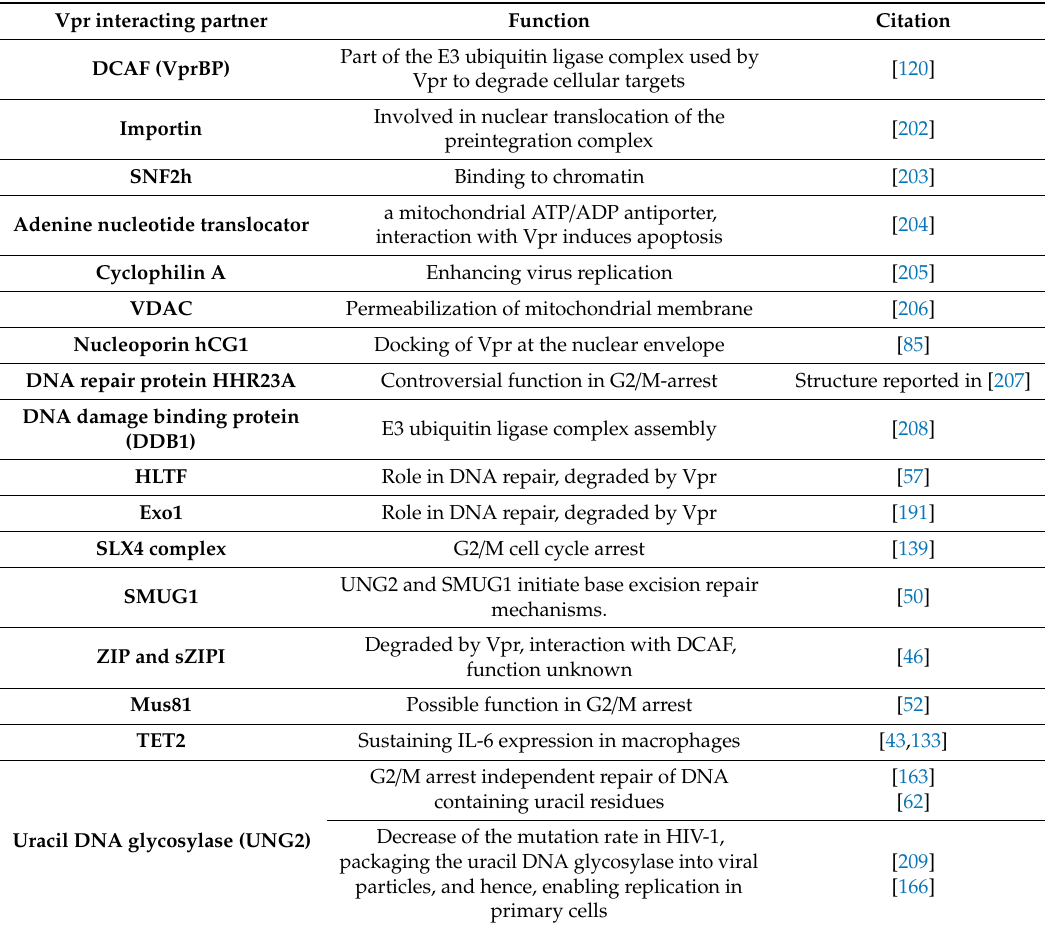
Table 2. Table of Vpr interacting